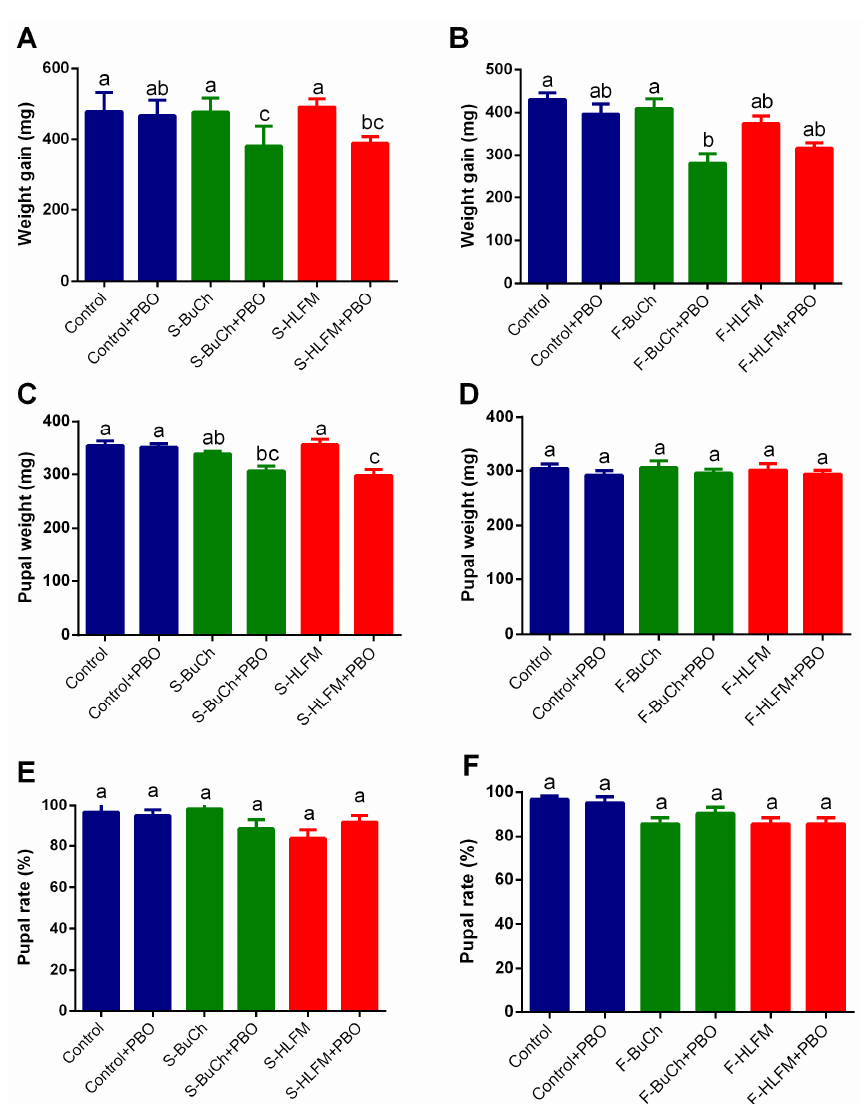
differences between control group (Control) and herbicides treatments (S-BuCh, S-HLFM, F-BuCh, and F-HLFM) on weight gain, pupal weight, and pupation rates (Figure 3, p > 0.05). Although three treatments pre-treated with PBO showed slightly lower than the larvae without PBO pre-treating (Figure 3A–C, S-BuCh + PBO vs. S-BuCh, S- HLFM + PBO vs. S- HLFM and F-BuCh + PBO vs. F-BuCh on weight gain; S- HLFM + PBO vs. S- HLFM on pupal weight), most treatments showed no significant differences. These results suggest that exposure to herbicides did not affect growth and development of H. armigera and induce resistance of H. armigera accompanied with no fitness cost.